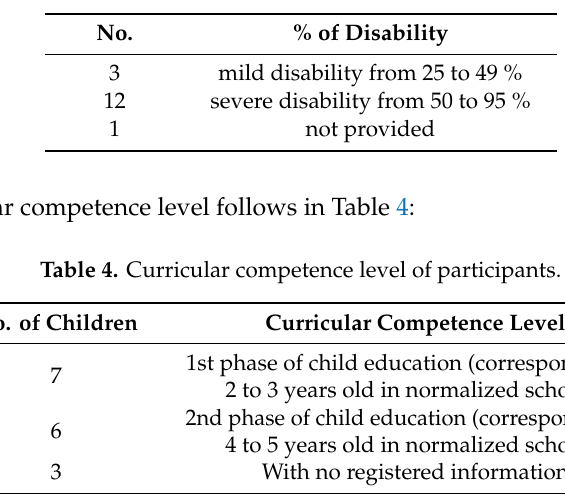
Table 3. Disability degrees of participants.